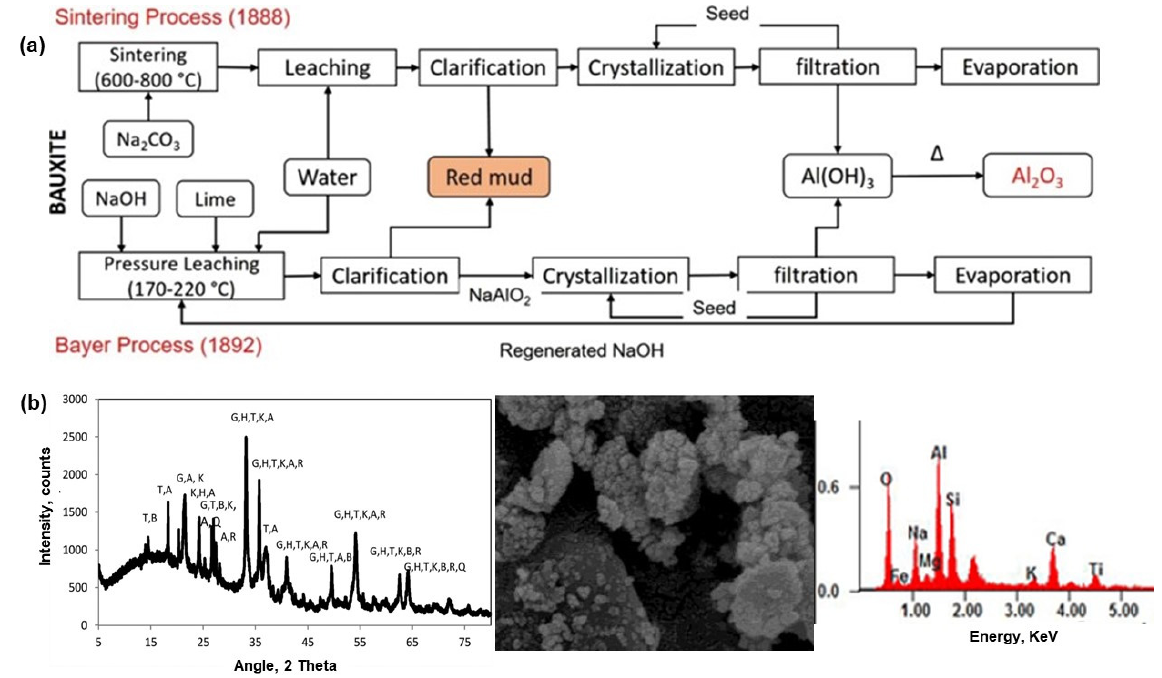
Figure 5. ( a ) Schematic for the extraction of alumina from bauxite using Bayer’s and sintering process, while generating red mud as the industrial waste [50]. ( b ) A typical XRD and SEM-EDX analysis of the red mud sample [60]. Table 4. The chemical and mineral composition of different types of red mud